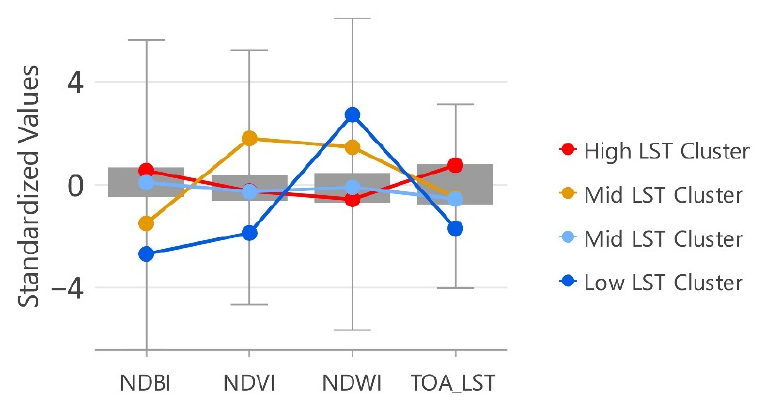
Figure 8. Boxplot of the multivariate cluster analysis result.